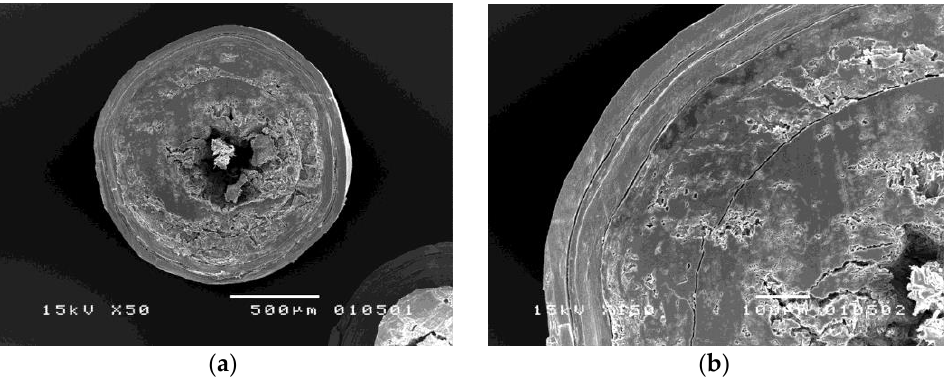
Figure 5. SEMs showing cross-sectional views at ( a ) 50× and ( b ) 150× magnification of the Ca/P/Ca/P-coated metoprolol tartrate pellets.